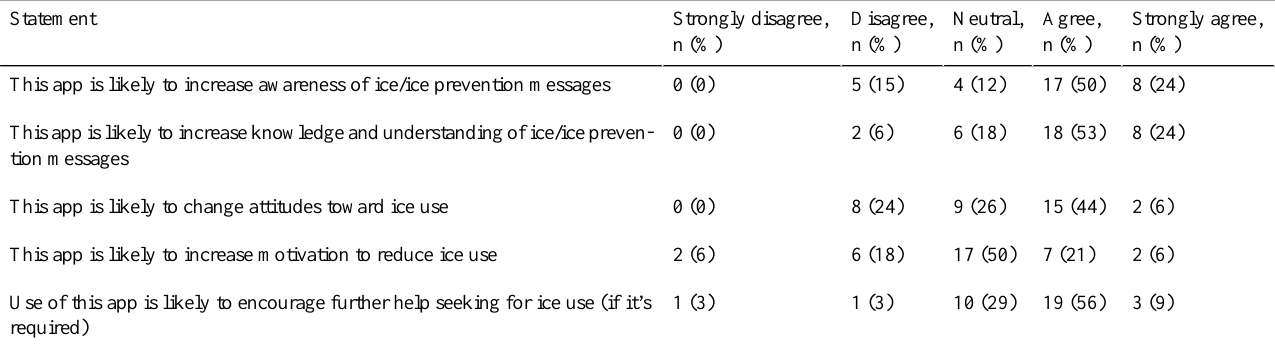
Table 4. Agreement with statements regarding app’s impact on awareness, knowledge, understanding, attitudes, motivation, and behavior.